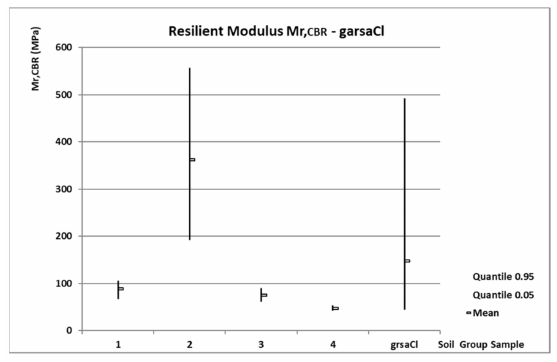
Figure 6. Statistical quantities—mean, 0.05 quantile, 0.95 quantile of M r,CBR for grsaCl soil.